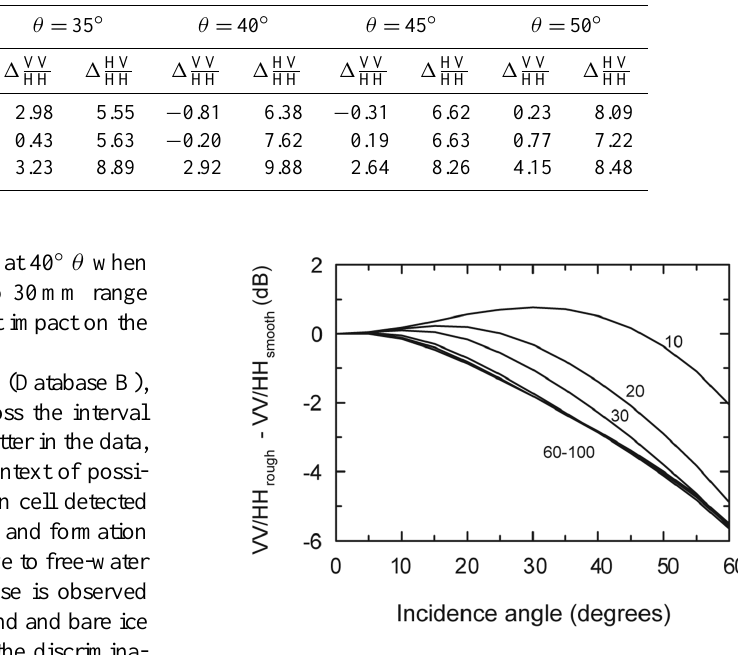
Figure 10. Role of varying l w on the difference between IEM- modelled VV / HH from rough ( s w = 7mm) and smooth ( s w = 1mm) ponds. Values in the plot refer to l w in mm used in each